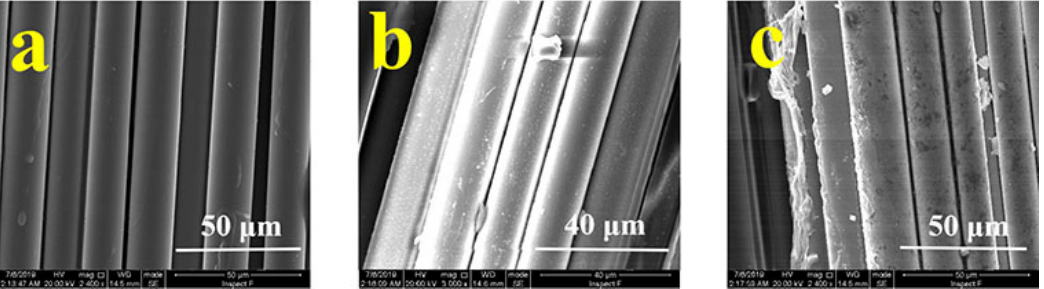
Figure 2. Scanning electron microscope (SEM) images of ( a ) basalt fiber (BF), ( b ) PBF and ( c ) MBF.